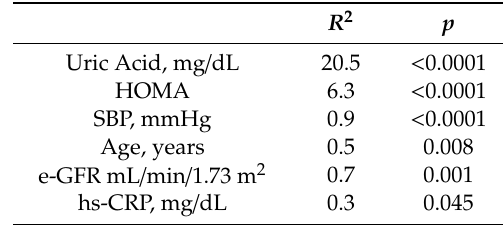
Table 4. Multivariate stepwise regression analysis on PWV as dependent variable in whole study population.